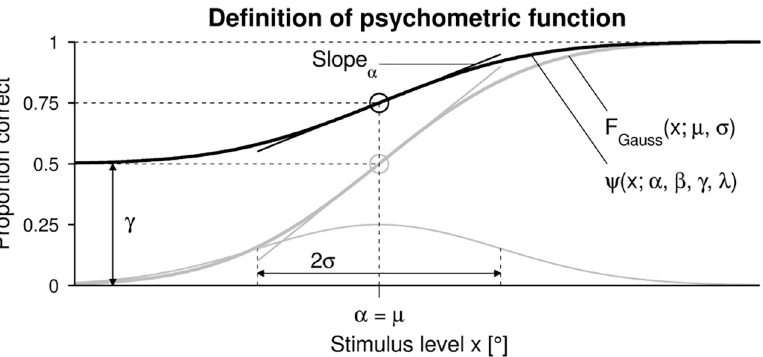
Fig 1. Psychometric function. Illustration of the psychometric function ψ ( x ; α , β , γ , λ ) (bold black sigmoid) and related parameters. The underlying cumulative normal function F ( x ; μ , σ ) (bold gray sigmoid) and its underlying Gauss normal probability density function (gray) are also indicated. The slopes are indicated at the inflection points in the same color of the corresponding sigmoids. Note that the psychometric function is illustrated for the present application of proprioceptive joint angle assessments using a 2AFC paradigm, where the stimulus level x corresponds to the angular difference between two stimuli to be distinguished in a trial in degrees (˚). In this application, γ was set to 0.5, λ to 0, and the difference threshold was defined at x T = ψ − 1 ( P t ), with P t = 0.75.